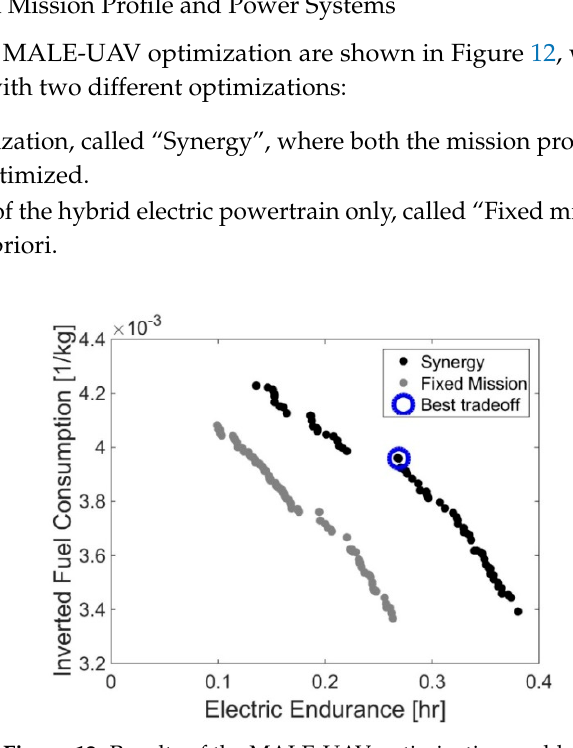
Figure 13. Profile mission of the “Best_tradeoff” solution of Test Case 2. Table 7. Specification of the “Best_tradeoff” solution of Test Case 2.